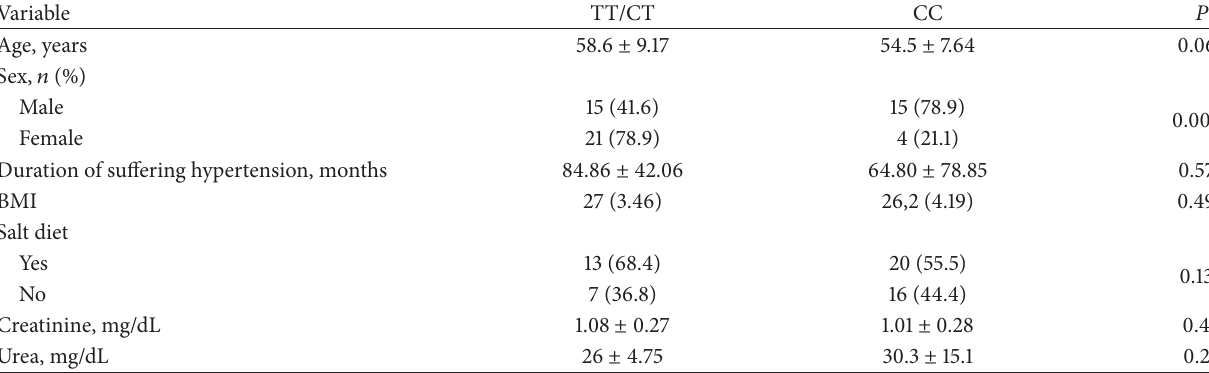
Table 1: Baseline characteristic of hypertensive